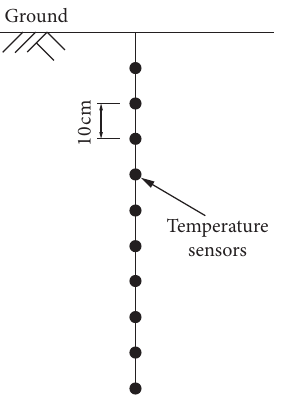
Figure 1: Layout of temperature